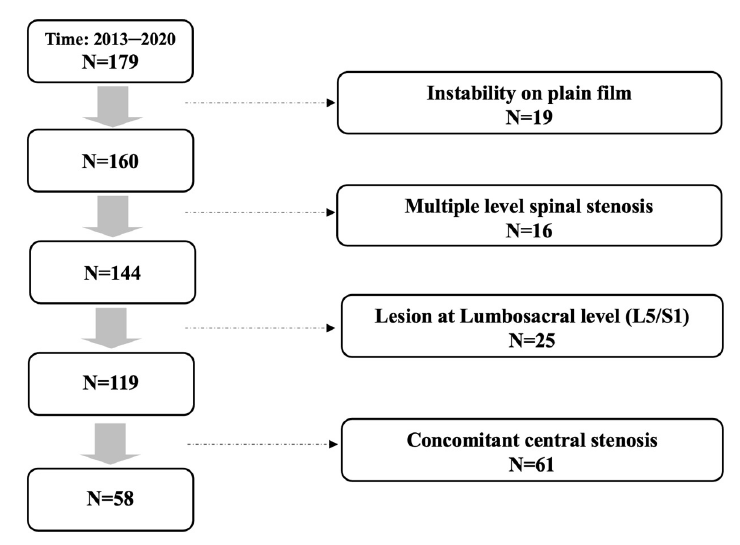
Figure 1. Patient inclusion flow diagram.